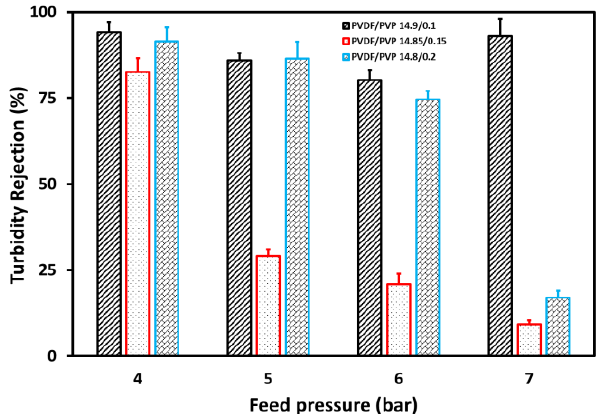
Figure 8. Turbidity rejection at various feed pressures in the UF process for tofu wastewater.